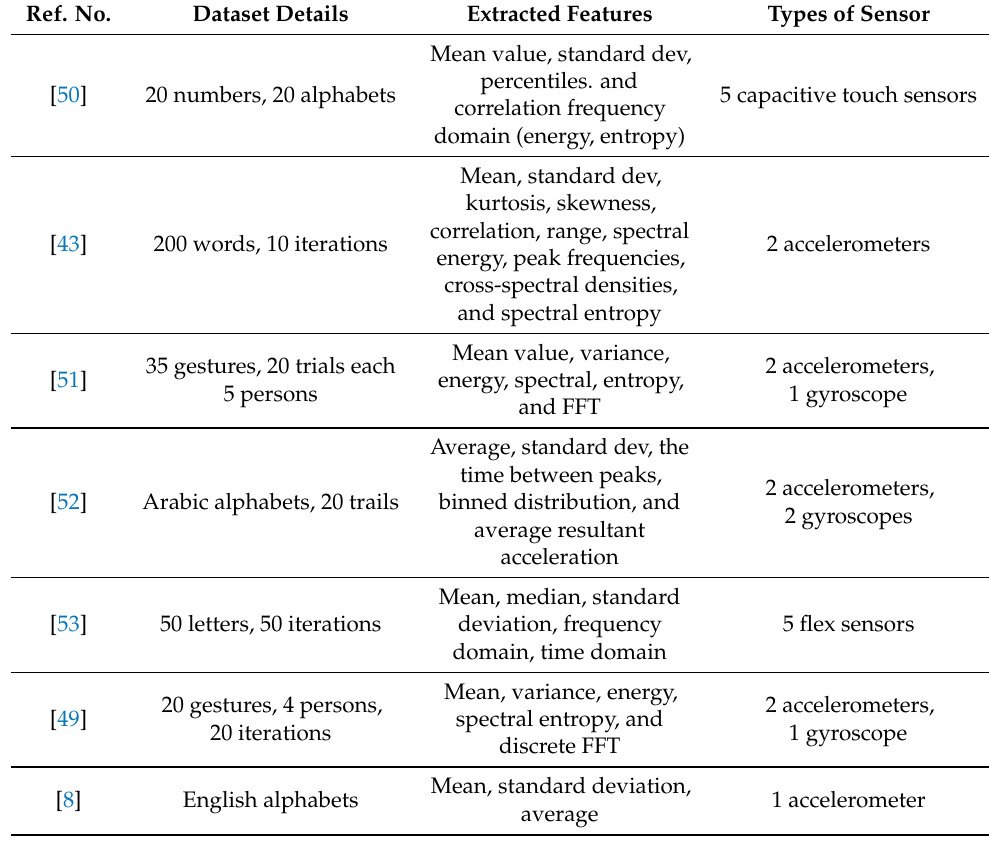
Table 1. Literature review focused on wearable sensors used for gestures and activity recognition.